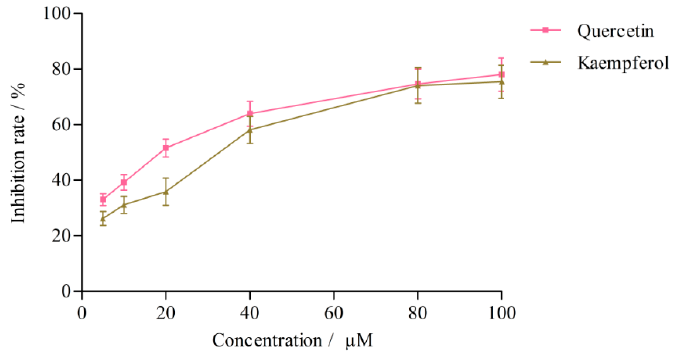
Figure 7. Effects of quercetin and kaempferol on CYP3A4 isozyme activities.